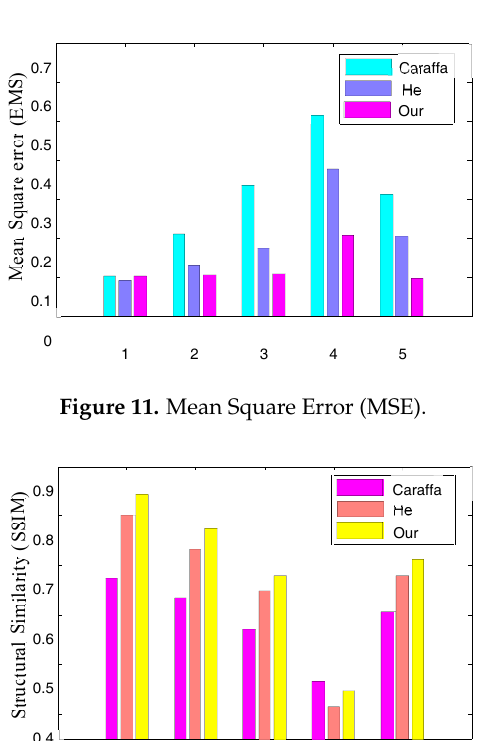
Figure 10. A comparison of the results of synthetic hazy images. ( a ) Synthetic hazy images; ( b ) Caraffa’s [15] results; ( c ) He’s [16] results; ( d ) Our results; and ( e ) ground truth images.